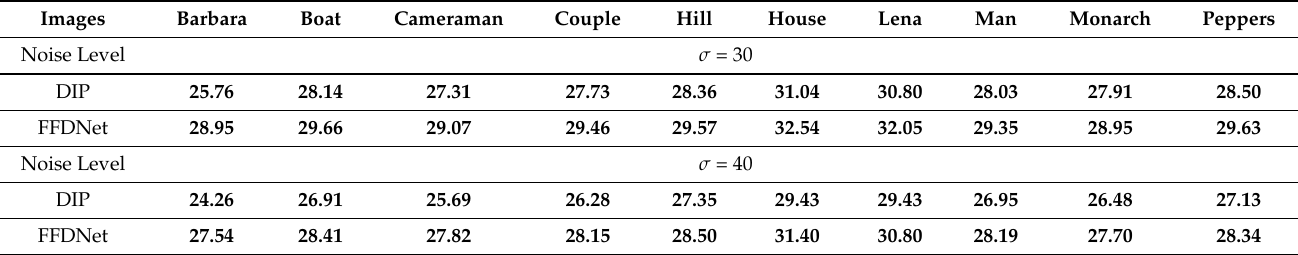
Table 1. PNSR(dB) results of DIP and FFDNet on 10 commonly used images with noise level σ = 30 and 40. Images